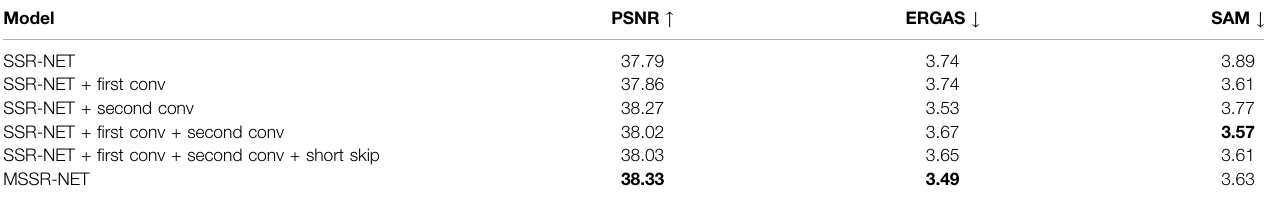
TABLE 11 | Ablation experiments on Pavia Center dataset. Four spectral bands of HR MSI are generated according to Type 1 model and LR HSI is 4×